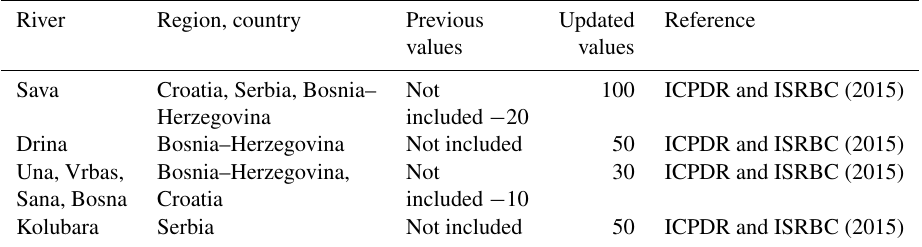
Table A1. Update of the flood protection level map developed by Jongman et al. (2014), used for the risk assessment procedure.